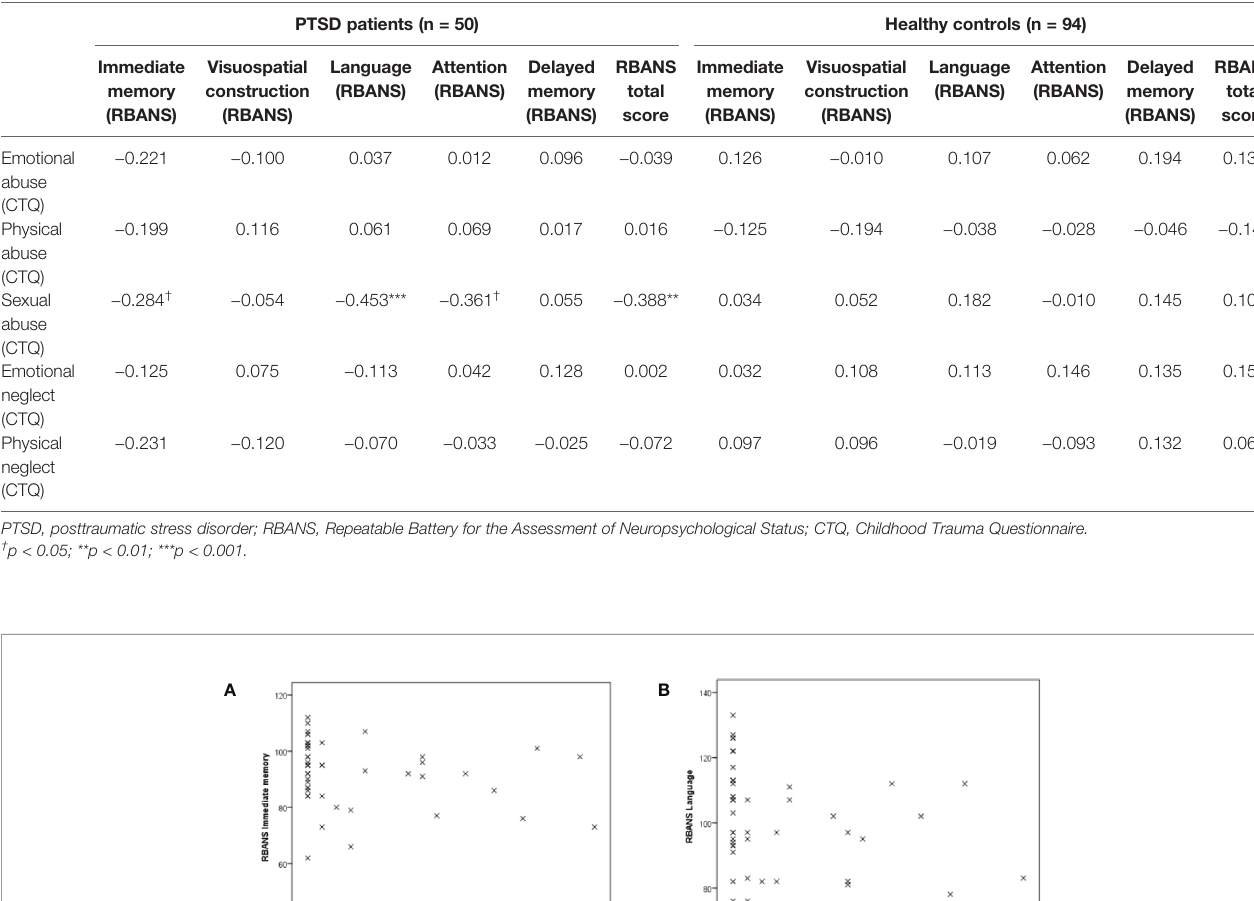
TABLE 2 | Correlations between childhood maltreatment and cognitive function in PTSD patients and healthy controls (calculated by Spearman's r